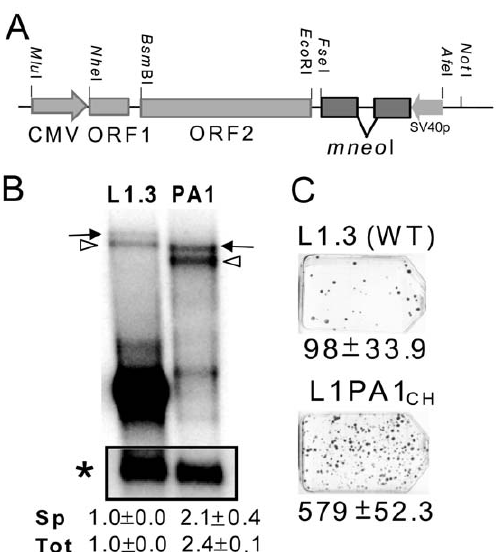
Figure 1. Codon optimized minimal human L1 is retrocompe- tent. A . Schematic of the optimized human L1 construct. The CMV promoter drives the transcription of the fully optimized ORF1 and ORF2 for L1 RP . The L1 vector is tagged with the mneoI indicator cassette containing an inverted neomycin resistance gene. The SV40 promoter (SV40p) drives transcription of the neomycin gene which is disrupted by an intron in the opposite orientation that renders it non-functional [16]. The intron is only spliced out from tagged L1 transcripts generated by the CMV promoter. When retrotransposition of the spliced L1 RNA occurs, the new insert will contain a functional neo gene that is expressed from the SV40 promoter. Only retrotransposed copies of the spliced RNA will confer G418 resistance. Some of the unique restriction sites used in the construction of the other vectors are shown. B . Northern blot analysis of the RNA profiles, 48 hours post- transfection, of transiently transfected HeLa cells with the tagged ‘‘wild type’’ L1.3 construct JM101/L1.3 (L1.3) and the tagged optimized minimal human L1PA1 CH mneo (PA1) using a probe to the 3 9 region of the neomycin gene. The full-length unspliced tagged L1 transcript (arrow) and the transcript with spliced neo tag (open arrowhead) are indicated. The inset shows the cyclophilin transcript (asterisk). The spliced (Sp) full length L1transcript and the total (spliced and unspliced; Tot) full length L1 RNA were normalized to cyclophilin and calculated relative to the L1.3 construct (designated as 1.0). The mean 6 the standard deviation for the quantitation results for each construct is indicated below (n=2). The highly expressed low molecular weight band observed for L1.3 likely represents common splice transcript variants that exclude most or all of the L1 coding sequences previously shown to be produced by L1 elements [36]. C . The retrotransposition capability of L1PA1 CH and L1.3 was assayed in HeLa cells. The optimized minimal human L1 is retrotransposition